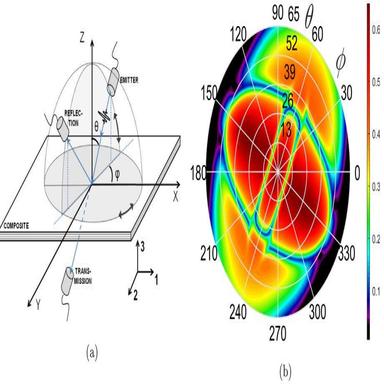
Illustration of the UPS (P-UPS) principle (a). Experimental pulsed UPS measurement (amplitude P-UPS) of a ° 8 carbon/epoxy plate at an f dc value of 5 MHz.mm, with a colorbar that is normalized to maximum amplitude of the incident field (b).